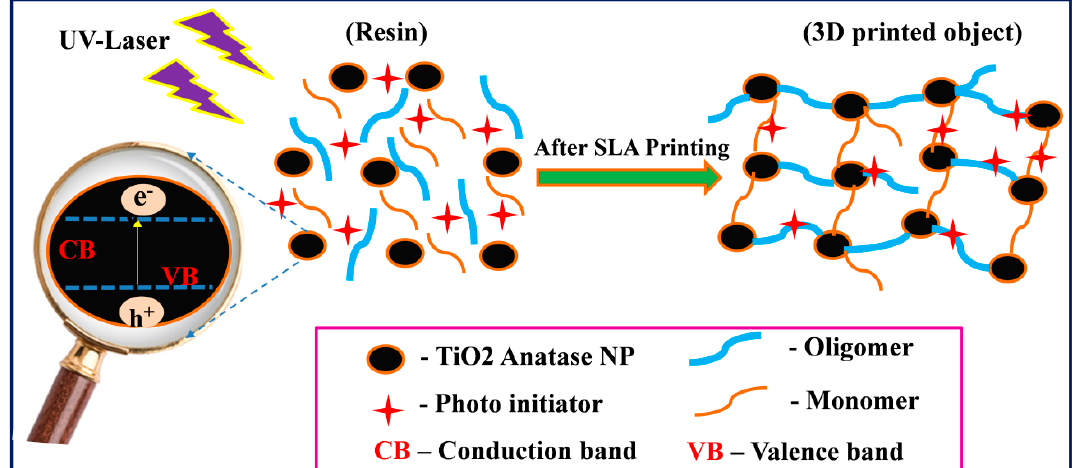
Figure 15. A schematic illustration of photopolymerization of photo resin with semiconducting anatase TNPs under UV light for the SLA 3D printing. Nanomaterials 2020 , 10 , 79